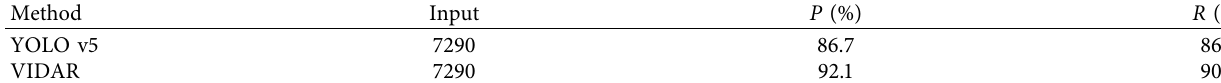
Table 3: The total results of both in the parking space detection experiment.